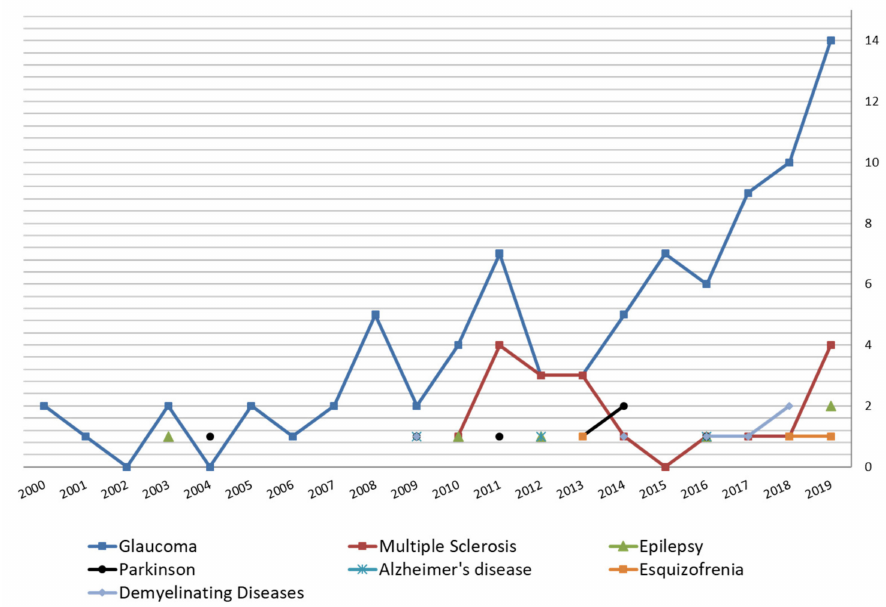
Figure 7. Chronological distribution of the documents according to the main